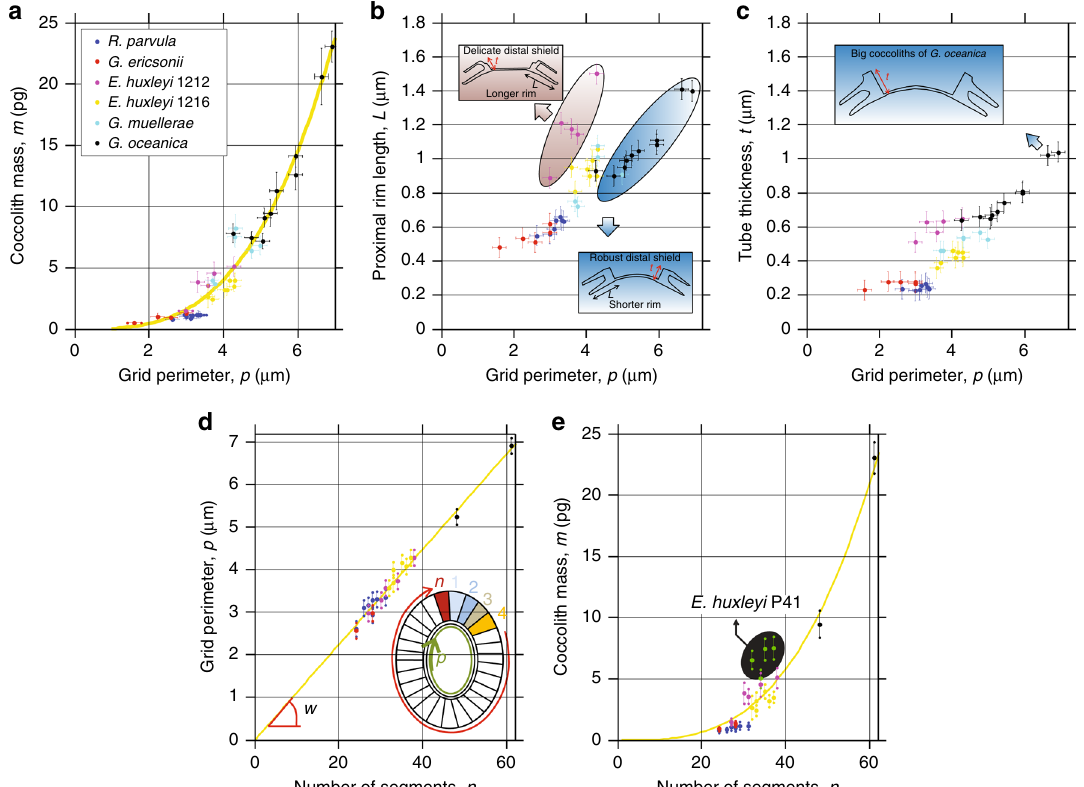
Fig. 4 Dependence of OBPS size on the number of segments and the mass of coccoliths. a Mass of coccoliths m as a function of the peripheral grid perimeter p for all species, except E. huxleyi P41 for which p cannot be determined because the out-of-plane thickness of the grid is comparable to that of the tube rendering impossible the identi fi cation of the frontier between the two elements. The yellow dotted line is m = k n × n β with k n = 4.73 × 10 − 5 , β = 3.175 and m in pg (coef fi cient of determination R 2 = 95%). b Proximal rim length L as a function of p . For a given p , coccoliths with short rims display robust distal shields (i.e., no space between the elements) while coccoliths with long rims display delicate distal shields (slit between the elements). c Tube thickness t as a function of p . d p as a function of the number of segments n for coccoliths from fi ve different coccolithophore species. The equation of the dotted line is p = w × n with p in µ m and w = 0.112 µ m. The slope w is equal to the average width of the tube at the periphery of the grid. For G. muellerae , the determination of n was not possible because the frontier between the successive segments is not resolved. For E. huxleyi P41 , p cannot be measured (see text above). e Mass of coccoliths as a function of n . The yellow dotted line is m = k n × n β with k n = 4.73 × 10 − 5 , m in pg. By excluding the data for E. huxleyi P41 (shown in green) for which the central area of the coccoliths (i.e., the grid) contains a signi fi cant amount of CaCO fi cient of 3 , the coef determination is R 2 = 3D-CXDI analysis was performed before SEM observations so that the cocco- spheres analyzed by 3D-CXDI were not metalized. CXDI measurements and reconstructions . CXDI is an X-ray imaging technique well suited for visualizing at few nanometers resolution the 3D nanostructure of isolated micrometer-sized objects, e.g., biological specimens 55,57 and material sci- ence samples 30,31,58,59 . We performed the CXDI measurements at the ESRF beamline ID10 30 . The X-ray beam produced by an undulator source was mono- chromatized by a Si(111) pseudo-channel cut monochromator. Beryllium com- pound refractive lenses were employed to focus the beam at the sample position. The coherent fraction of the beam was fi nally selected by roller-blade slits opened to 10 × 10 μ m and placed 0.55m upstream of the sample, giving essentially a plane- wave-like illumination 60 . A sketch of the experimental setup is shown in Supple- mentary Fig. 1A. The sample was mounted on a horizontal ultra-precision rotation stage equipped with x , y , z translations and an on-axis optical microscope. The microscopic samples were deposited on 100-nm-thick Si 3 N 4 membranes and kept fi xed by electrostatic forces. 2D diffraction patterns were recorded by a Maxipix detector having 516× 516 pixels of 55 μ m in size. The detector was placed 5.2 m The intersection at 0.5 threshold was used to estimate the real resolution (see for downstream of the sample and a vacuum fl ight tube was used to reduce air absorption and scattering. A beamstop was inserted in front of the detector inside instance ref. 31 ). The PRTFs were calculated for R. parvula , E. huxleyi RCC1216 , the vacuum fl ight tube to block the intense direct beam and protect the detector from radiation damage. A series of 2D diffraction patterns were recorded at sample tilt angles from − 80°(±5°) to + 80°(±5°) with 0.2° – 0.5° step. The average mea- surement time per sample was 1 – 8h with 4.5 – 25 s per frame. The 2D patterns were assembled into the 3D diffraction volume using linear interpolation. The real space image reconstruction was achieved by the iterative phase retrieval algorithm applied to the 3D diffraction volume (Supplementary Fig. 1B). Details of the phase